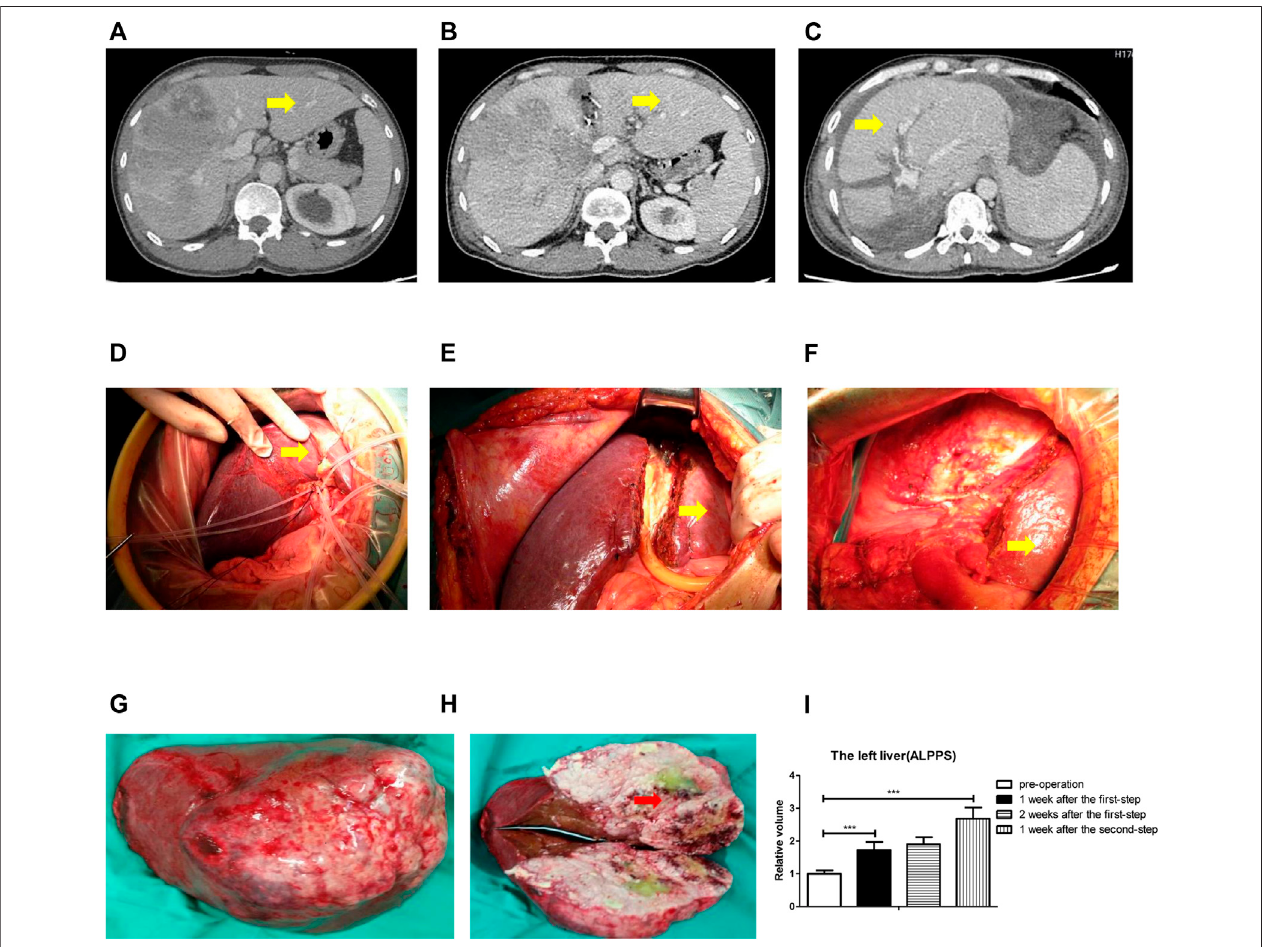
FIGURE1| ALPPScouldpromotehumanliverregeneration. (A) CTscanshowedtheliverbeforesurgery. (B) CTscanshowedtheliver2 weeksafterthe fi rst-step surgery. (C) CT scan showed the liver 1 week after the second-step surgery. (D) Right branch of the portal vein was ligated. (E) Ischemic line was separated. (F) Right hepatectomy on the patient. (G) Right hepatic tumor was completely resected. (H) Tumor was atrophic with ischemic necrosis. (I) Calculation of the left liver relative volume with a CT scan at four different time points: before operation, 1 week after the fi rst-step operation, 2 weeks after the fi rst-step operation, and 1 week after the second-step operation. The quanti fi cation is presented as mean ± SD, ***p < 0.001.